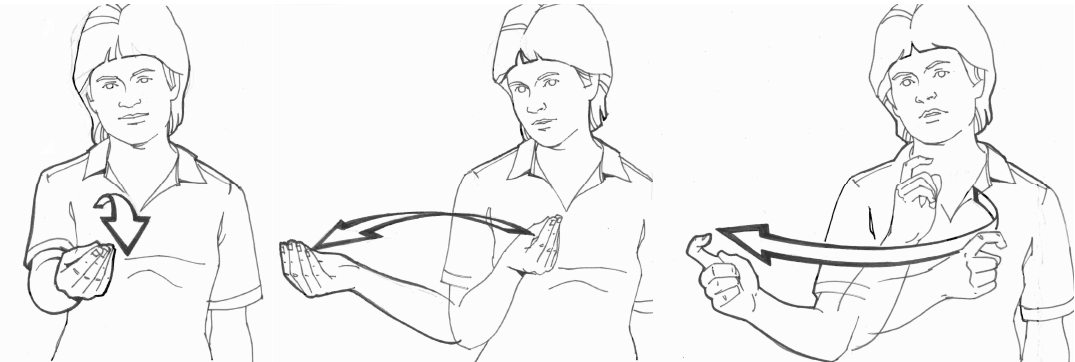
Figure 3. Some examples of verb agreement in ASL. ( a ) I-GIVE-YOU, ( b ) I-GIVE-HIM, ( c ) (I-)GIVE- ALL. With permission from Carol Padden. (Spatial agreement with subjects other than first person, not pictured, also occurs regularly in ASL and other sign